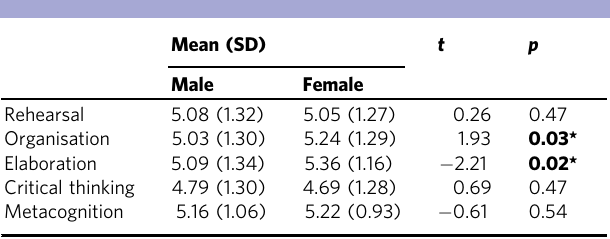
Table 6 Gender differences in cognitive learning strategies